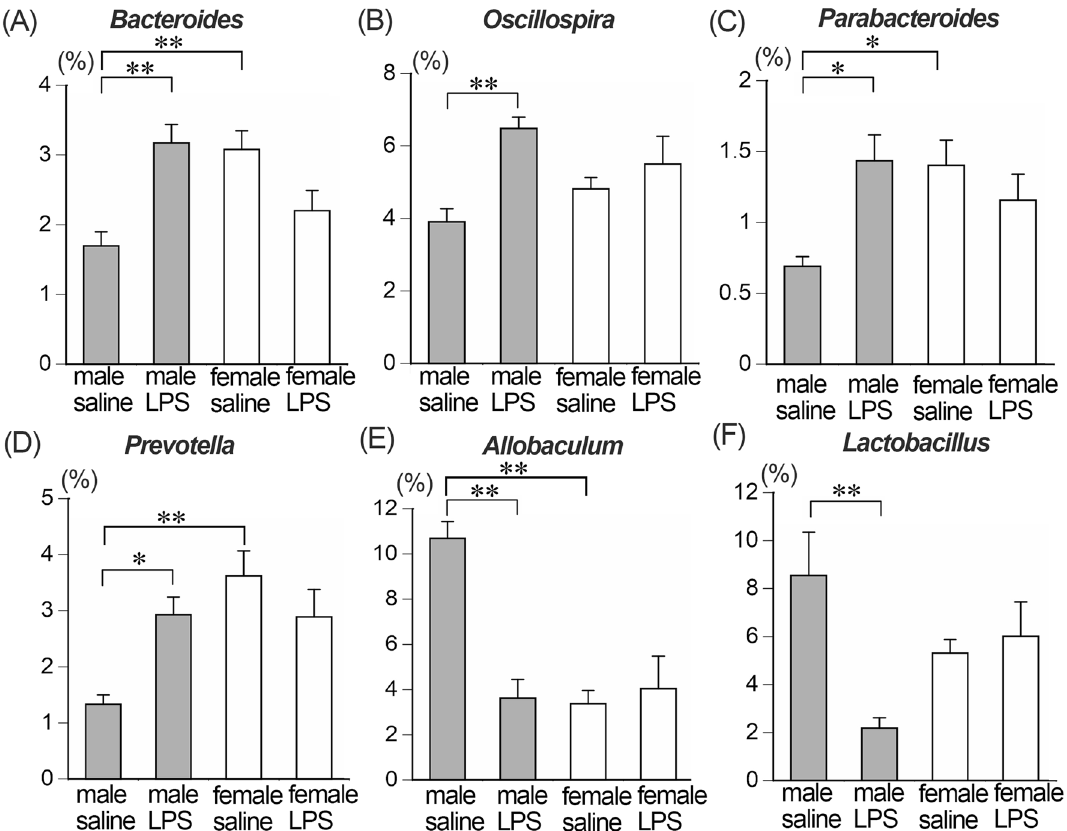
Figure 4. The relative abundance of gut microbiota at genus level. Significant increases in the abundances of Bacteroides ( A ), Oscillospira ( B ), Parabacteroides ( C ) and Prevotella ( D ) and decreases in Allobaculum ( E ) and Lactobacillus ( F ) in male LPS-treated compared to male saline-treated mice were detected. No significant changes in the abundance in female LPS-treated compared to female saline-treated mice were detected. * p < 0.05, ** p < 0.01. n = 5 for each